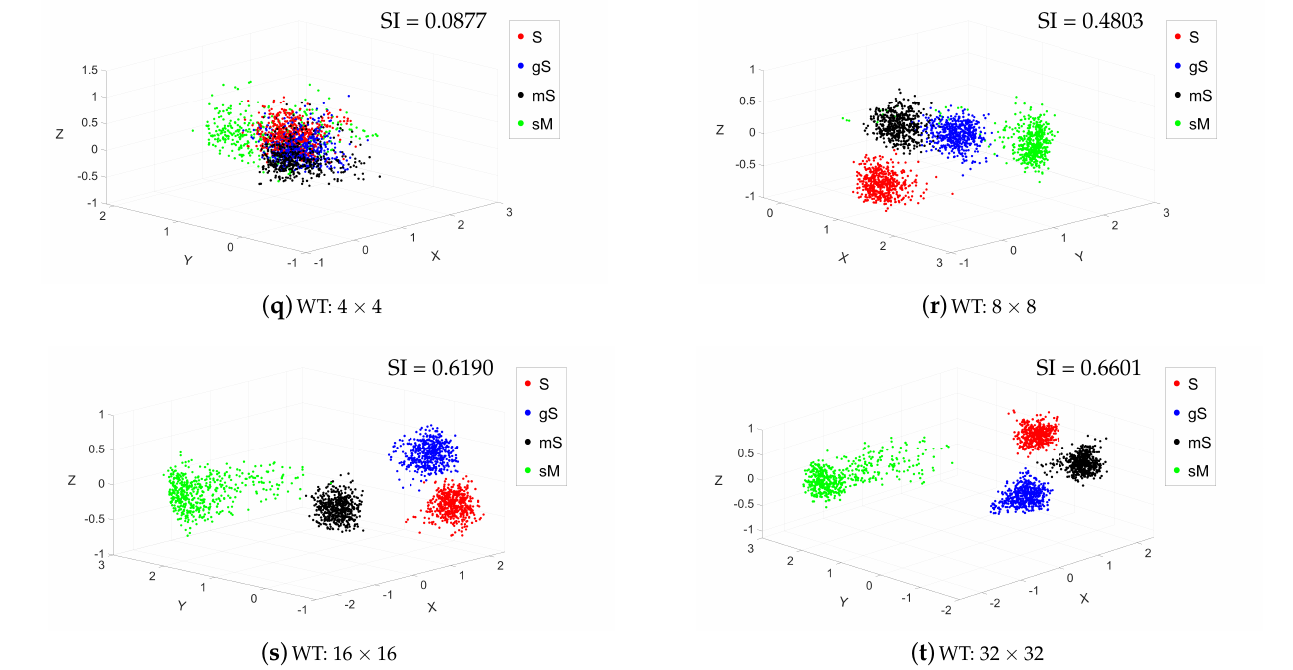
Figure 7. Discriminability of five feature extraction methods in four scales.